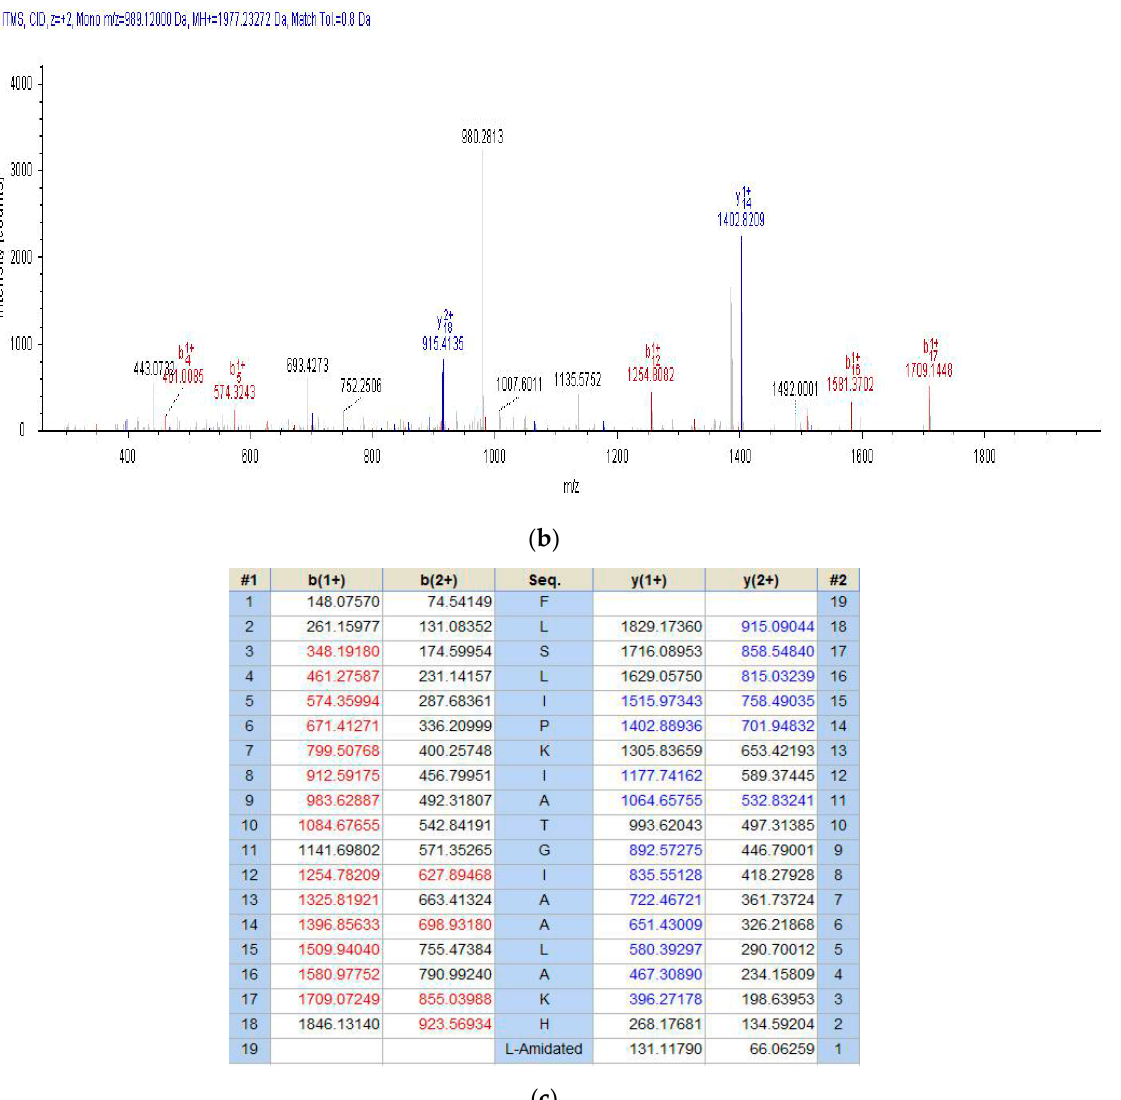
Figure 3. ( a ) Reverse phase high performance liquid chromatography (HPLC) chromatogram of skin secretion of Phyllomedusa camba monitored at 214 nm. The arrow indicated the retention time of PSN-PC; ( b ) Tandem mass (MS/MS) fragmentation spectrum of PSN-PC; ( c ) Predicted singly-charged b ions and y ions arising from MS/MS fragmentation. The observed b- and y-ions were indicated in blue and red typefaces.